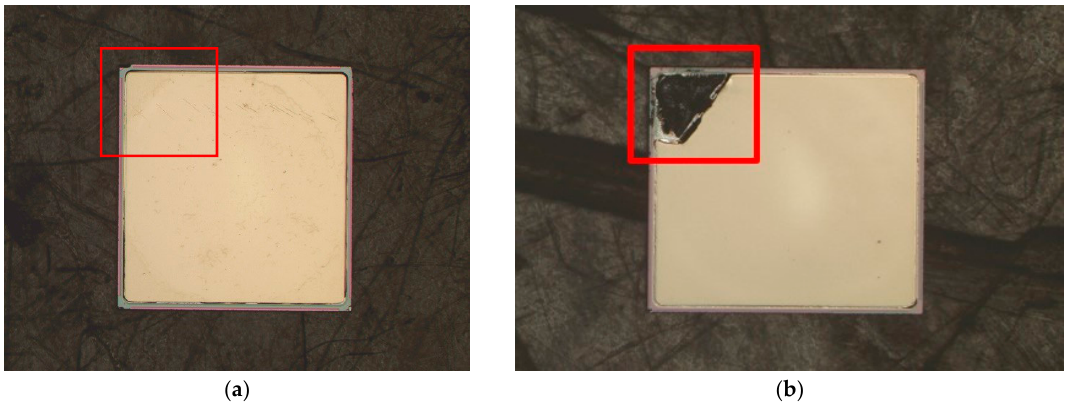
( b ) Figure 7. X-ray analysis images ( a ) normal bypass diode, ( b ) failed bypass diode. For further study, die-inspection of both diodes was conducted. Die-inspection is a commonly used tool to probe defects in electrical components during their manufacturing and operation. For die-inspection, the de-capsulation of EMC was conducted using a chemical etchant as a pretreatment process. After de-capsulation, the surface of the junction was scanned using an optical microscope.